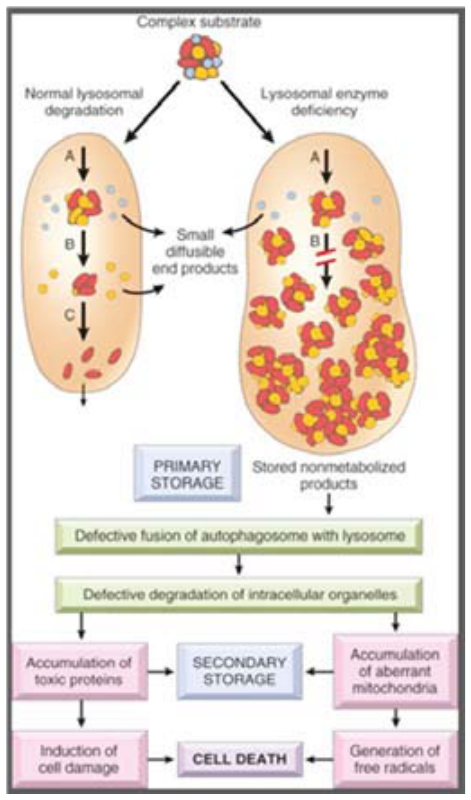
Fig 1: Pathogenesis of lysosomal storage diesease (Kumar et al.,